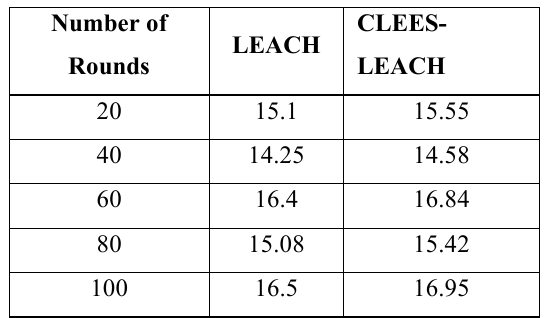
Table 5. Comparison of Average Residual Energy